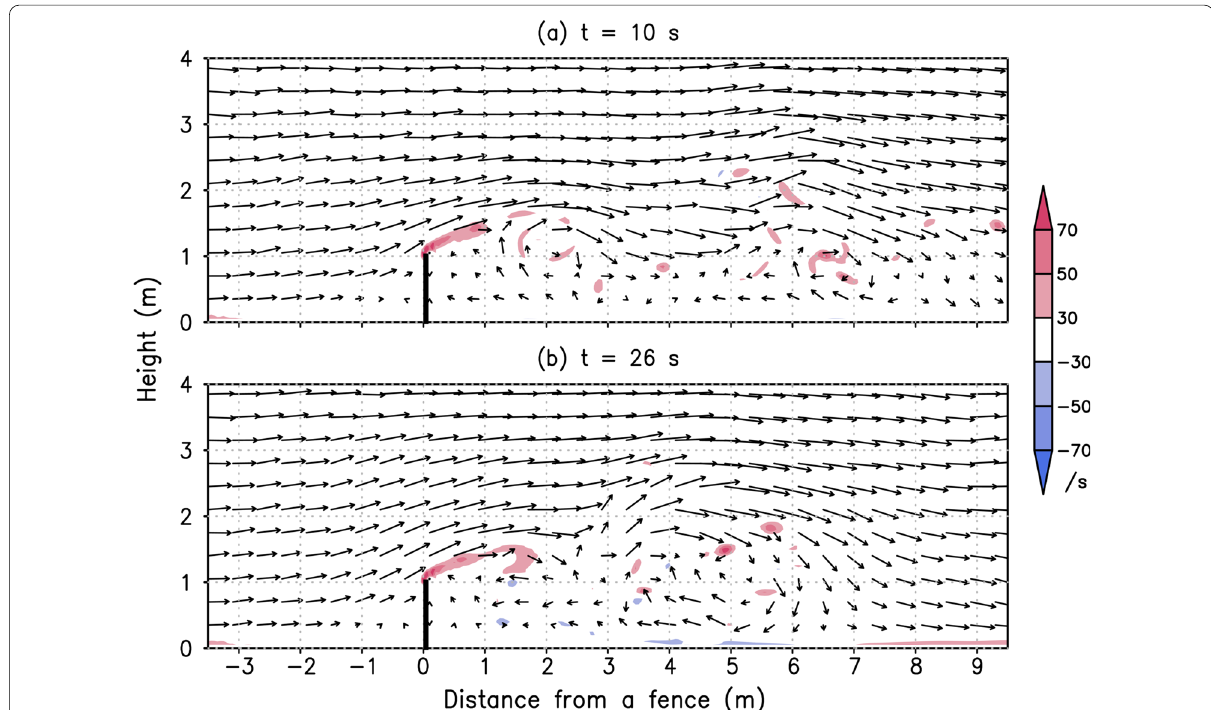
Fig. 7 Snapshots of the wind vectors (vectors) and vorticity (shading) around the two-dimensional fence in the cross section along y 10 and b 26 s. The solid line at x 0 shows the two-dimensional =